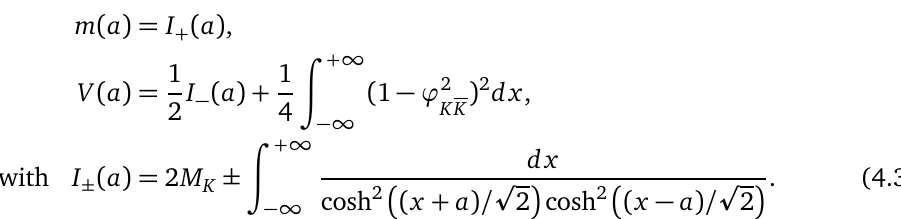
Figure 4.1: The effective potential V in the collective coordinate approximation, as a function of the separation a between kinks. The dashed line at V = 2 M asymptotic value of the potential. The green arrow on top schematically indicates an inelastic reflection of the kinks, while the red arrow tending to the bottom of the potential well shows the formation of a quasi-long-lived